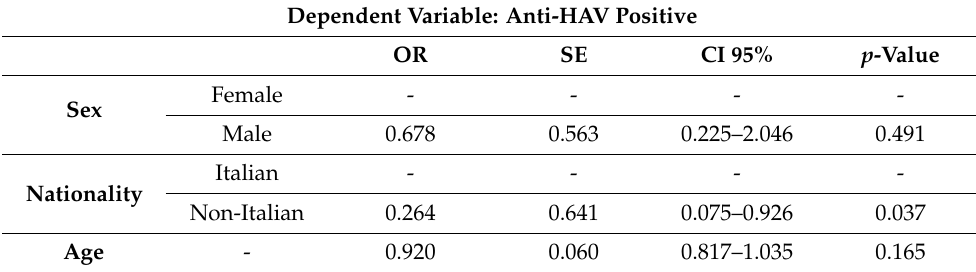
(Table 3). Table 3. Multivariate logistic regression Table 3. Multivariate logistic regression analysis.